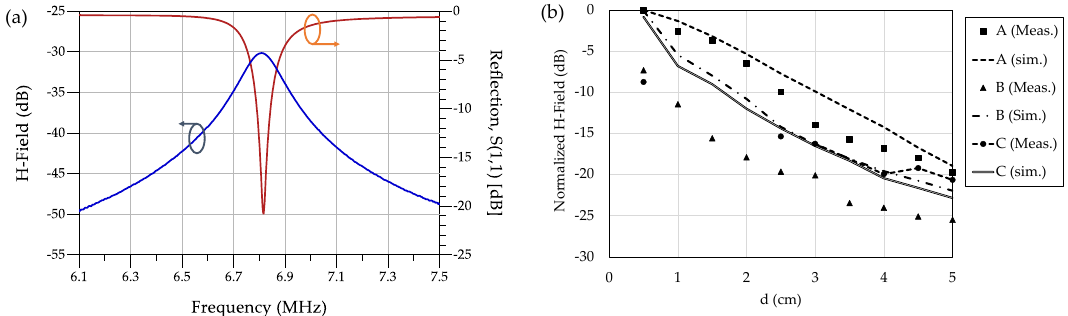
Figure 10. Near-field scans of the coil: ( a ) measured two-port transmission between the coil and the H-field prob, ( b ) simulated and measured normalized H-field at points A, B and C from Figure 9.